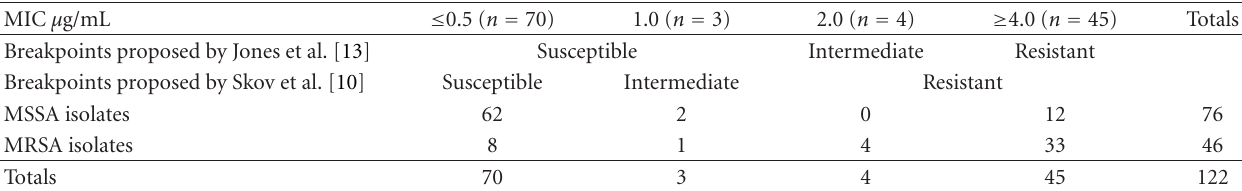
Table 1: Comparison of MIC interpretive criteria for S. aureus and fusidic